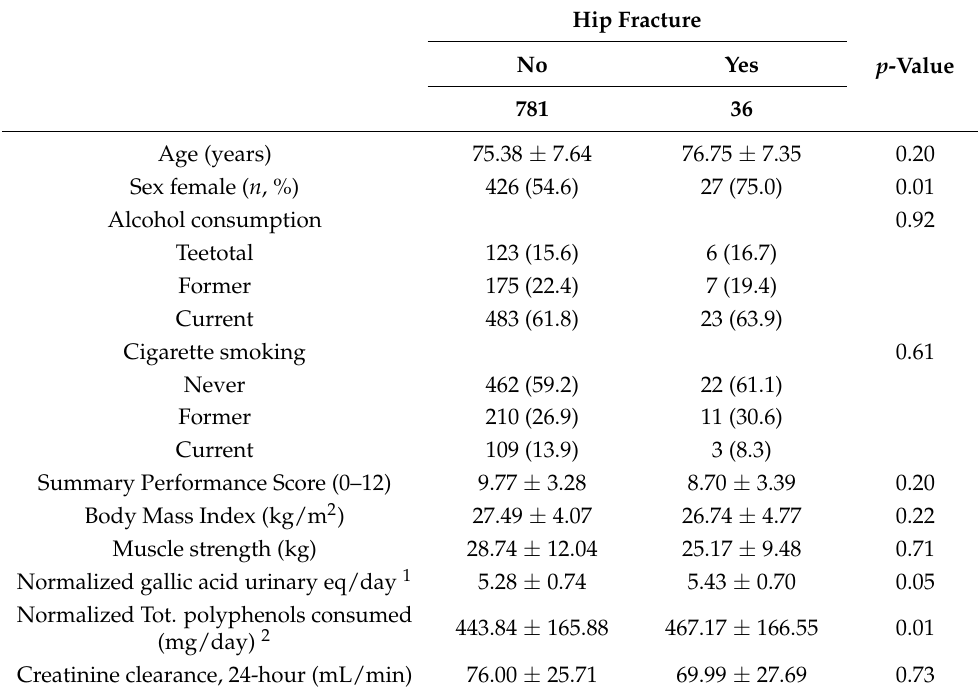
Table 1. Baseline characteristics of the population according to incident hip fractures. All p -values were age- and sex-adjusted. Normalized gallic acid urinary eq/day p -value was also adjusted for 24 h creatinine clearance.